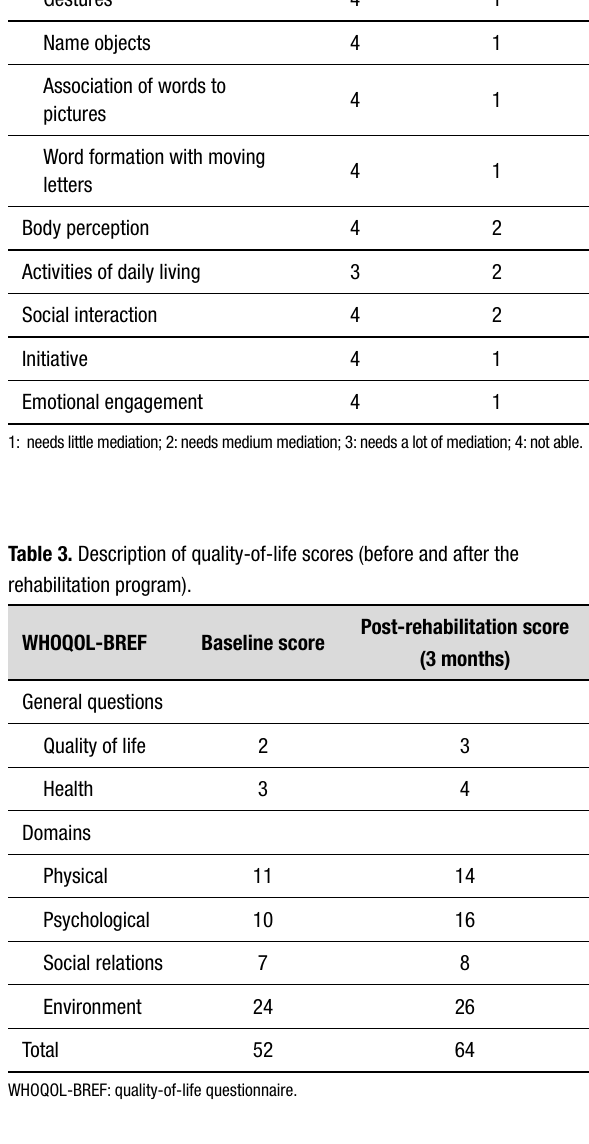
WHOQOL-BREF: quality-of-life